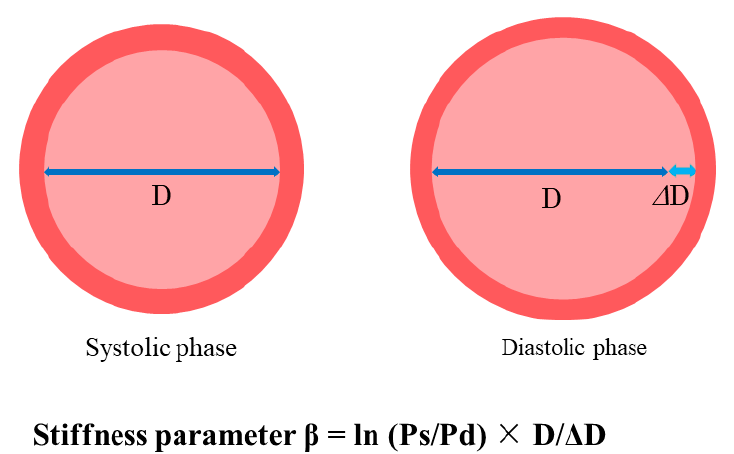
Figure 2. Principle of stiffness parameter β . Stiffness parameter β represents arterial distensibility, which is derived from the measurements of diameters in one section. This index was originally used for cervical and carotid arteries. Ps: systolic blood pressure, Pd: diastolic blood pressure, D: diameter of the artery, Δ D: change in diameter.